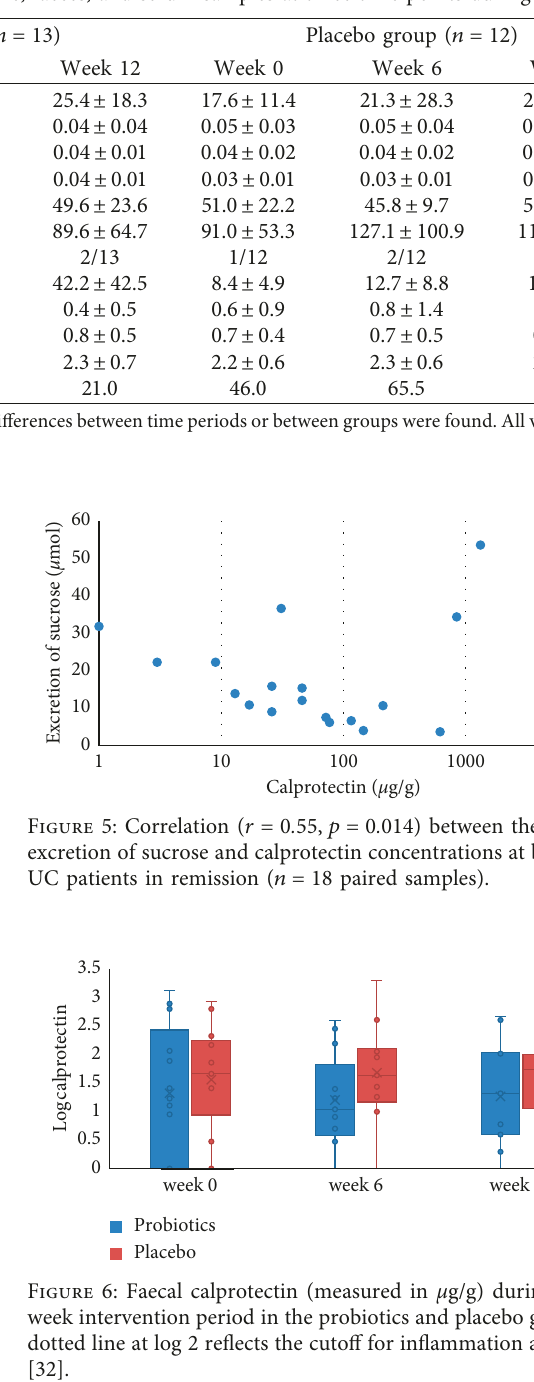
Table 1: Intestinal permeability and inflammation measured in urine, faeces, and serum samples at three time points during the study.